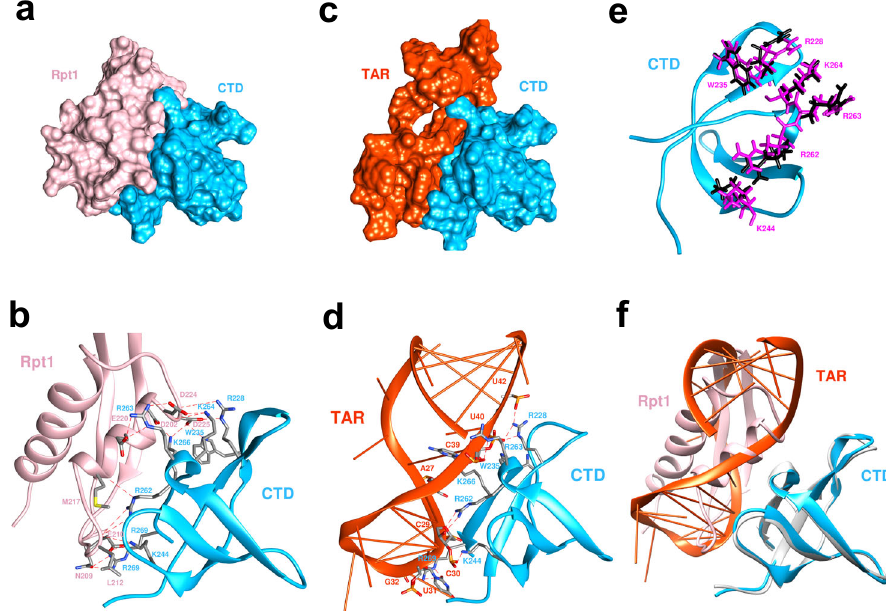
Fig. 7 Molecular docking studies to compare Rpt1 INI1 183-304 and TAR binding to IN CTD. a and c Surface representation of bound modeled complexes of CTD/Rpt1 and CTD/TAR. b and d Ribbon diagram showing interface residues of CTD/INI1-Rpt1 and CTD/TAR complexes. INI1-Rpt1 cartoon and residue labels are shown in pink, CTD cartoon and residue labels are shown in blue, and TAR cartoon and nucleotide labels are shown in reddish-orange. Note that interacting phosphate groups, bases, and sugars are shown. e Orientations of the key residues on CTD after docking shown in magenta (interacting with INI1-Rpt1) or black (interacting with TAR). f Superimposition of the CTD/Rpt1 and CTD/TAR complexes shows the identical orientation of CTD and nice overlap of Rpt1 and TAR RNA regions. In all panels, IN-CTD is represented in bright blue, INI1-Rpt1 in pink, TAR RNA in orange colors respectively. PDB fi les of models in this fi gure are included in Supplementary Data